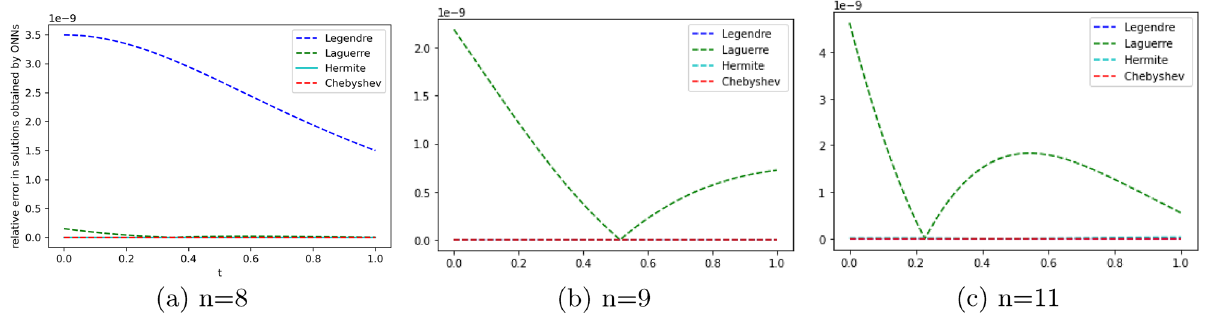
Figure 6. Error graph for different orthogonal neural networks with different numbers of neurons for Example 6.3.